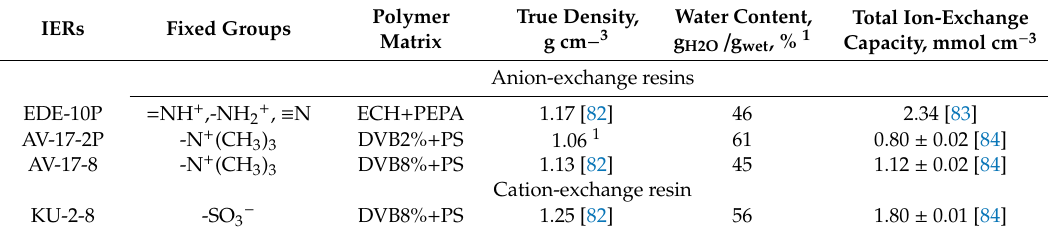
Table 2. Some characteristics of the ion-exchange resins determined in the present